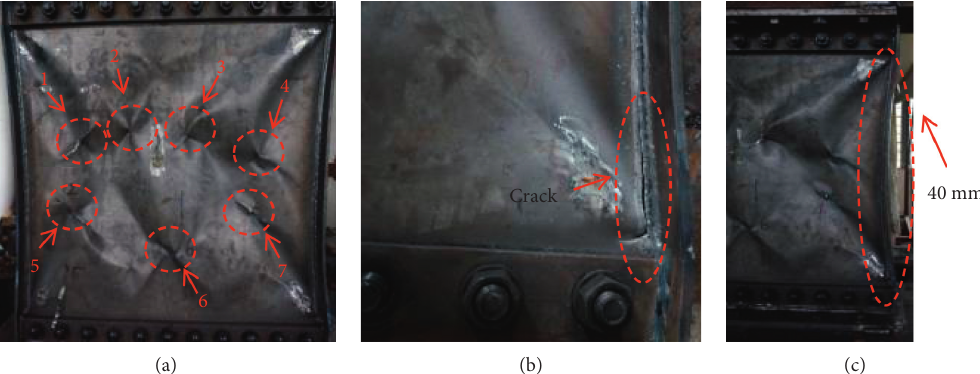
Figure 12: Destruction of SPSW specimen. (a) Cracks on the steel plate surface. (b) Crack in the corner of the steel plate. (c) Inward bending of the steel plate.